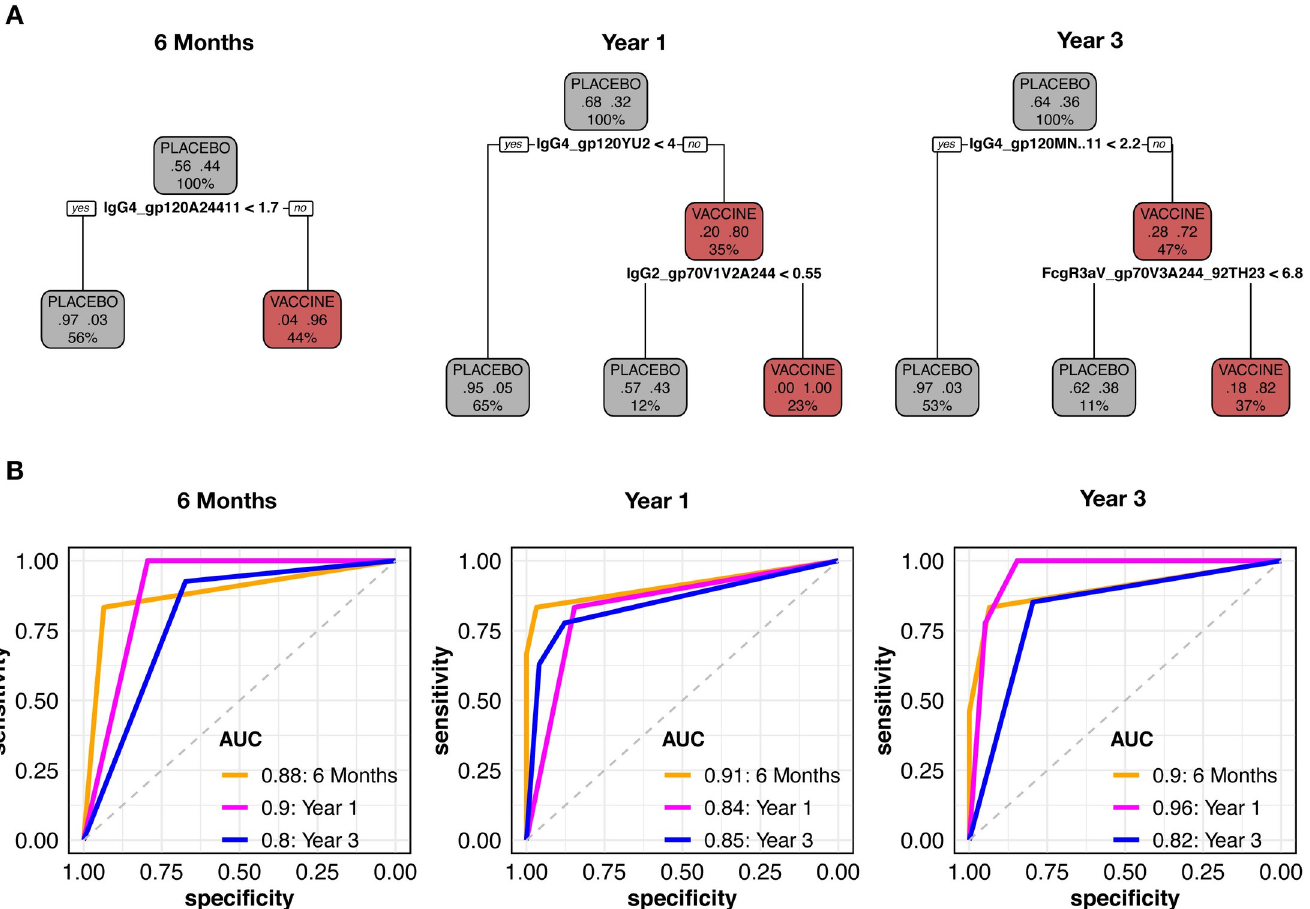
Fig 3. IgG4 gp120 features were the most informative to classify the vaccine group. (A) Representative CART trees generated with the top non-redundant predictors which classified vaccine (red) and placebo recipients (black). (B) ROC curves were generated for CART models corresponding to each time point and tested with data from the other time points. AUC generated with the data used to train the model were evaluated through cross-validation while AUC at other time points (time points with data that were not used to train the model) were evaluated by testing the model with these data. achieved a significantly higher balanced accuracy compared to group-permutated null models ( S4 Fig ).